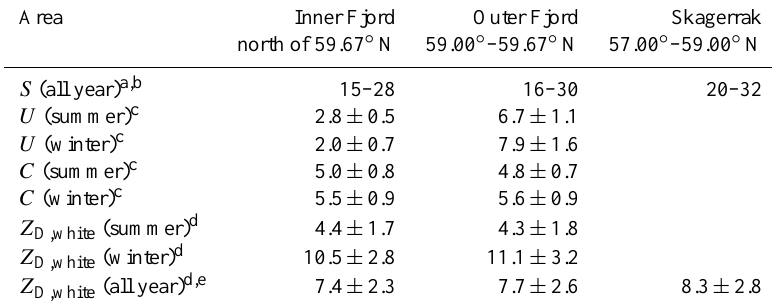
± sd of Secchi depth in D,white is mean